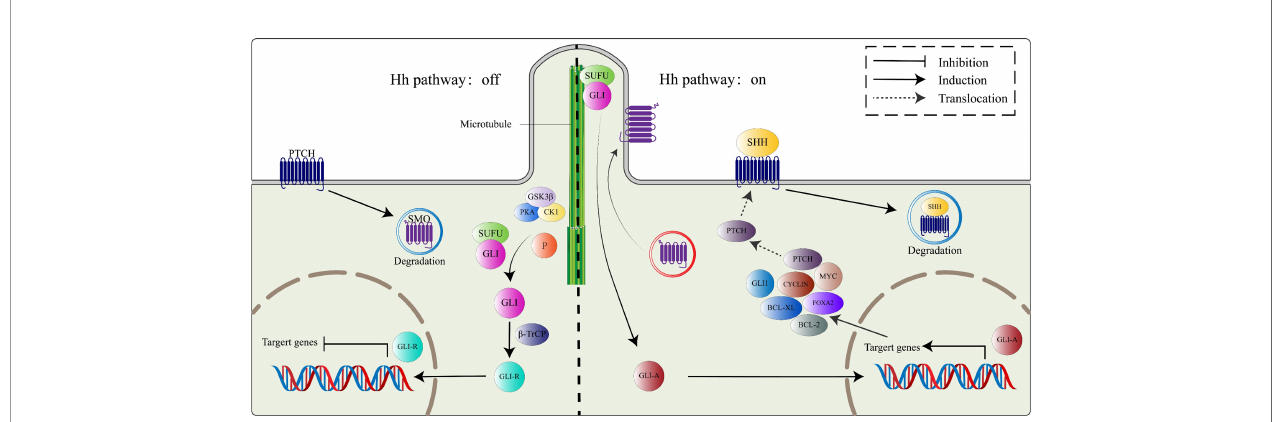
FIGURE 1 | The canonical HH signaling pathway. In the absence of the HH ligand (left), PTCH binds SMO, leading to its degradation. Microtubule complex containing Gli and SUFU is phosphorylated by GSK3 b /PKA/CK1 to activate Gli proteins, which subsequently combine with b -TrCP to switch into transcriptional repressor (GLI-R). In the presence of HH ligand (right), SMO restriction by PTCH is relieved, active SMO moves to the primary cilium. Active Smo interacts with the SUFU/GLI complex, localized at the top of the primary cilium, GLI proteins from the complex switch into transcription activators (GLI-A), which then translocate to the nucleus and activate the HH target genes, including PTCH, GLI1, FOXA2, BCL-2, BCL-Xl, MYC, and CYCLIN family among